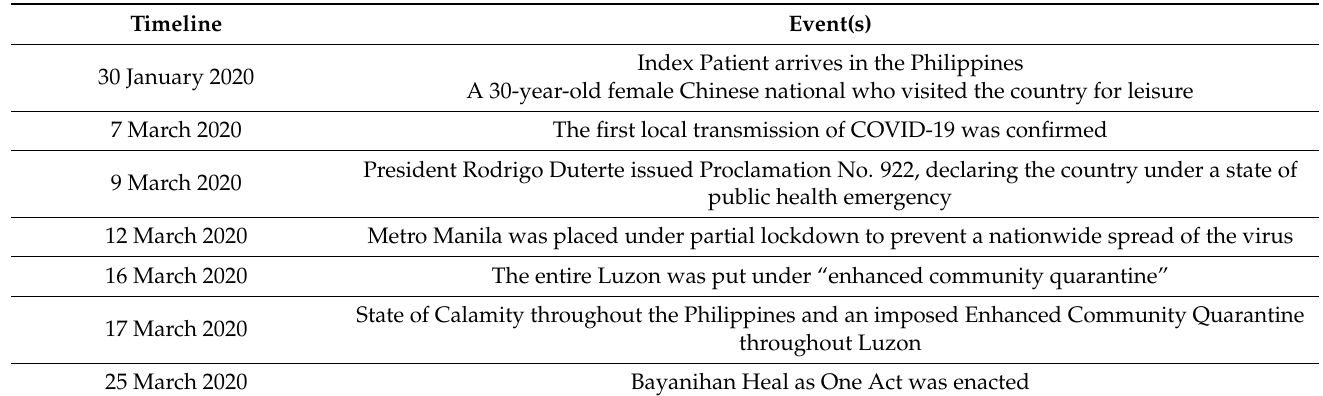
Table 1. Key events of COVID-19 pandemic in the